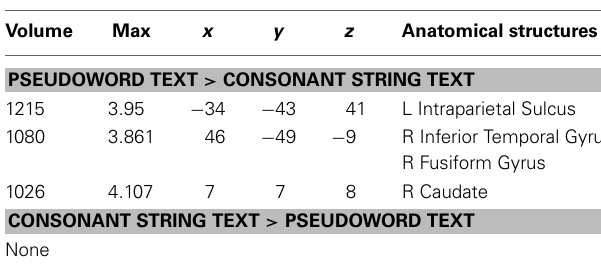
Table 6 | Talairach coordinates, volume of the cluster ( µ l), maximum z-score, and the label of anatomical structure for the pseudo text vs. the consonant string text analysis, L, left hemisphere; R, right